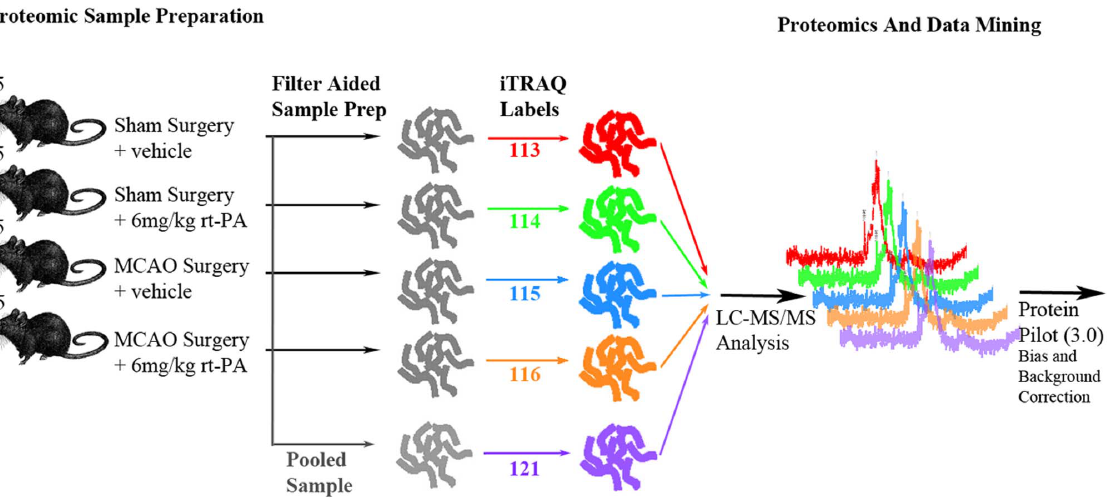
Figure 1. Schematic of 2D LC-MS/MS experimental design. Five iTRAQ labels were used: 113 for the Sham + distilled water injection. 114 for the Sham + rt-PA infusion. 115 for tMCAo + distilled water injection. 116 for tMCAo + rt-PA infusion. 121 for a pooled sample containing equal amounts from each group. Treated rats were given 6 mg/kg rt-PA 4 hrs after occlusion. All samples were pooled after iTRAQ labeling and subjected to mass spectrometric analysis.